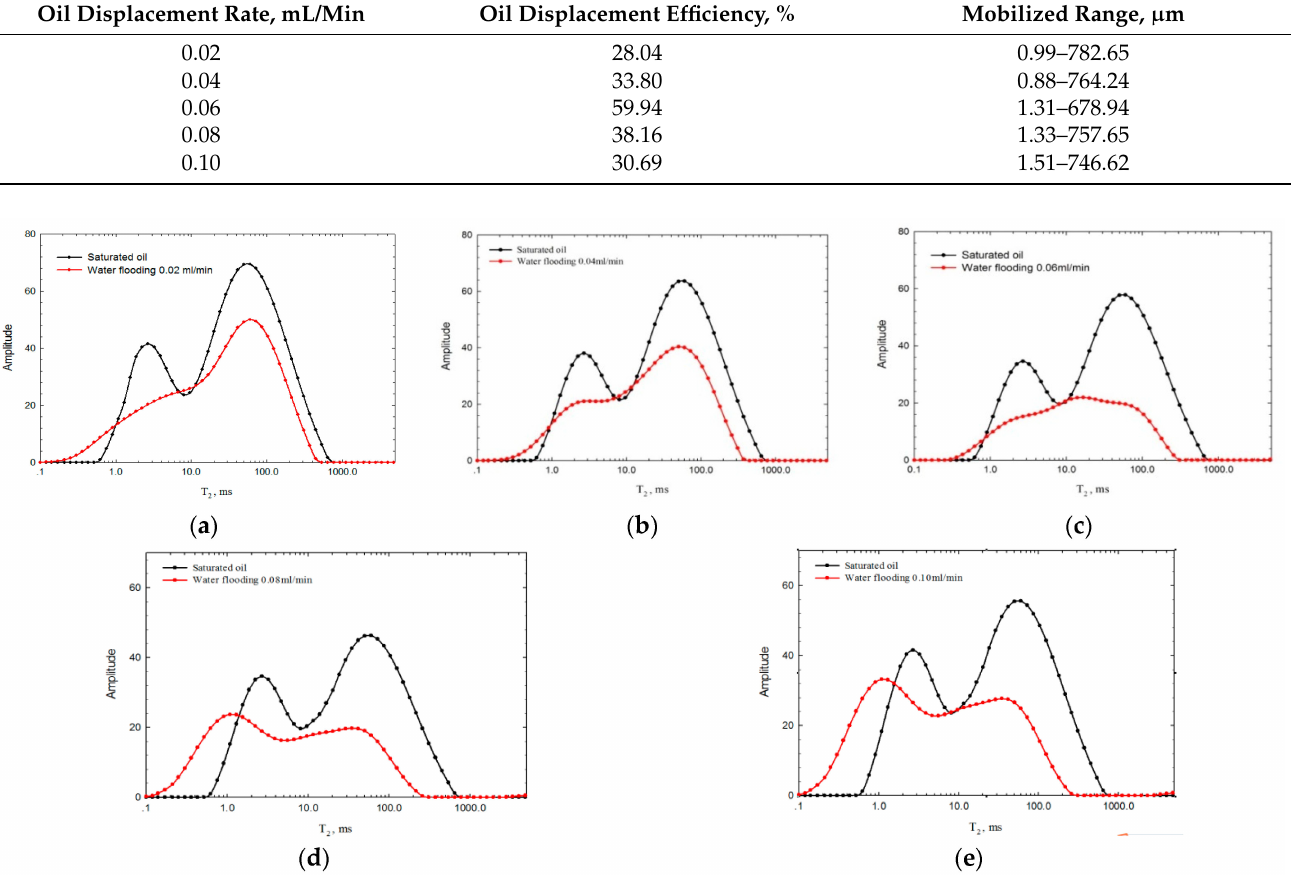
Figure 13. The T2 spectrum distribution curve at different displacement rate, 0.02 mL/min ( a ), 0.04 mL/min ( b ), 0.06 mL/min ( c ), 0.08 mL/min ( d ) and 0.10 mL/min ( e